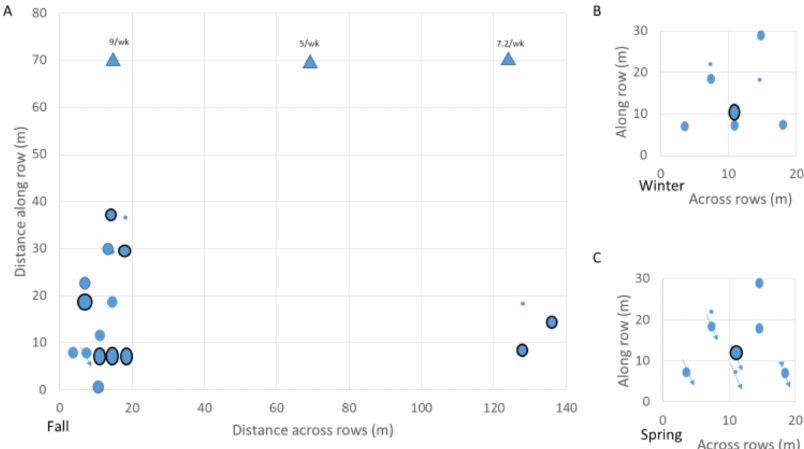
Figure 6. Infestation likelihood indicator values during ( A ) fall, ( B ) winter, and ( C ) spring seasons in vineyard sites of greatest activity: small ovals indicate mean between 0 and 0.5 (low infestation likelihood); larger ovals, 0.5 to 1.5 (medium infestation likelihood); and ovals with black outline, mean > 1.5 (high infestation likelihood); arrows mark sites where soil was excavated to identify grape root borer (GRB) larvae or larval damage to roots; and triangles denote location of three pheromone traps near the recording sites. Mean weekly trap counts are listed above trap location. Means at 17 sites are shown in ( A ), 8 in ( B ), and 8 in ( C